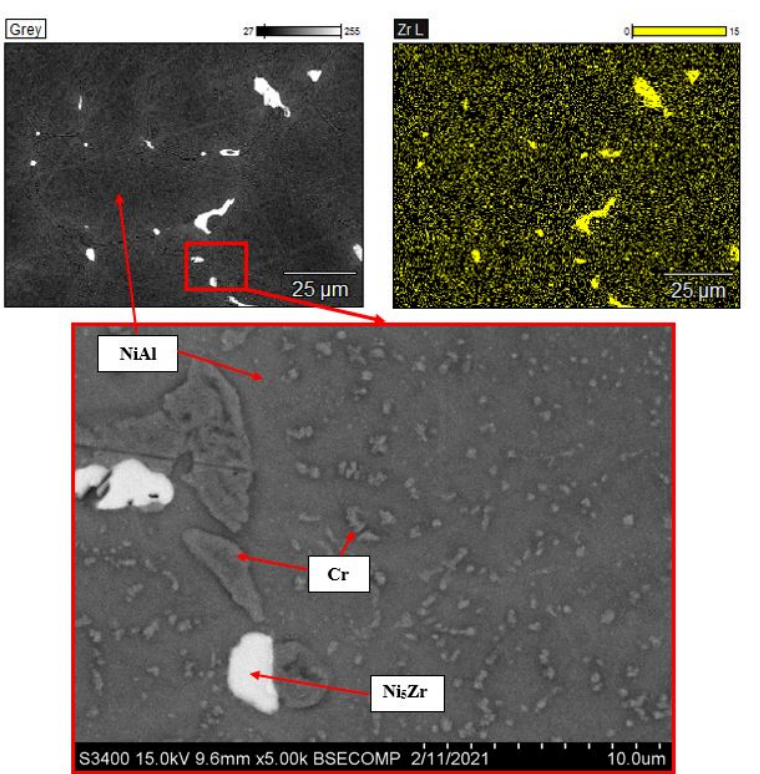
Figure 6. The microstructure of the alloy doped with 0.5% of zirconium and the map of dopant distribution. An analysis of the microstructures of the Ta-doped alloy (Figure 7) showed that the intergrain space contains precipitates of the Laves phase (Cr 2 Ta). The Ni 3 AlTa phase is supposedly formed along the grain boundaries (the light-gray areas). Figure 8b shows the results of microprobe analysis along the line within the intergrain space. One can see that interlayers of Cr-based solid solution Cr(Co,Ni,Al) reside between NiAl grains.